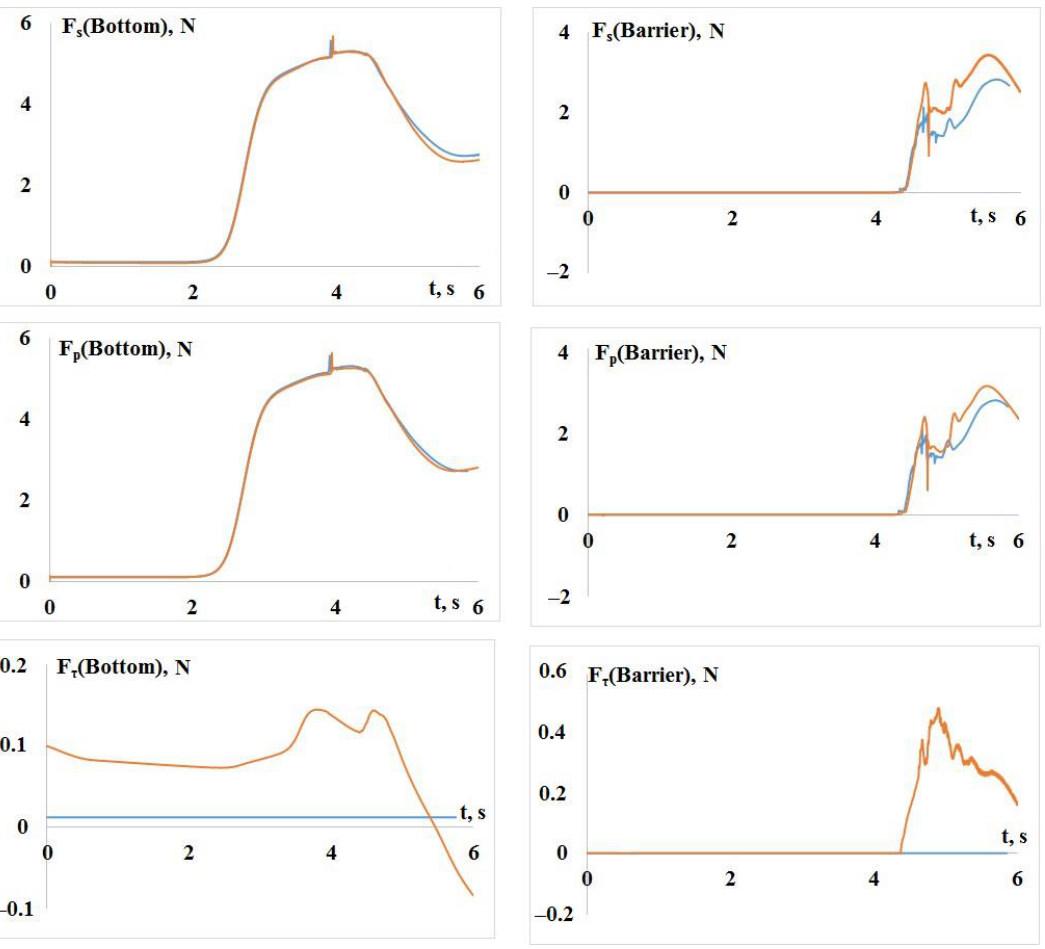
Figure 10. Comparison of the forces acting on the channel bottom in the slope and barrier zones for setup 3 ( —without TM, —with TM).